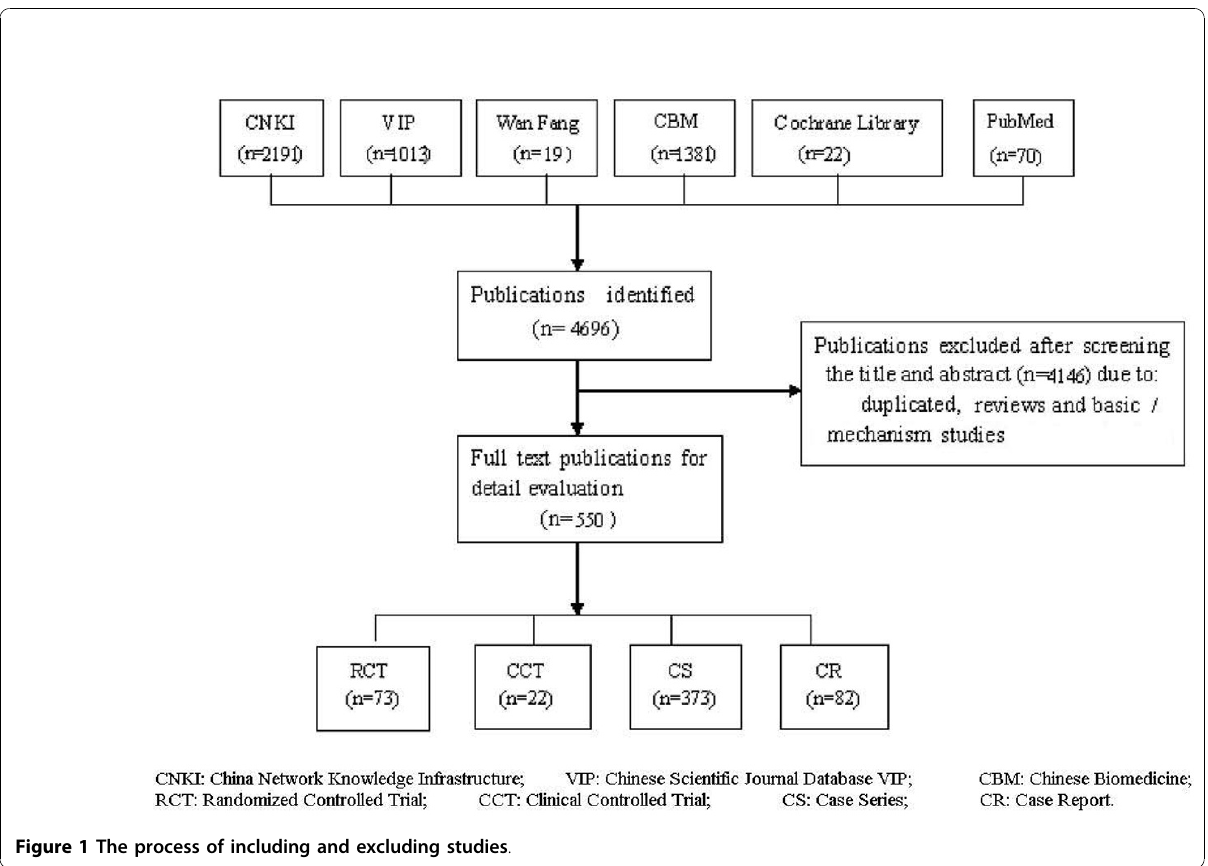
Figure 1 The process of including and excluding studies